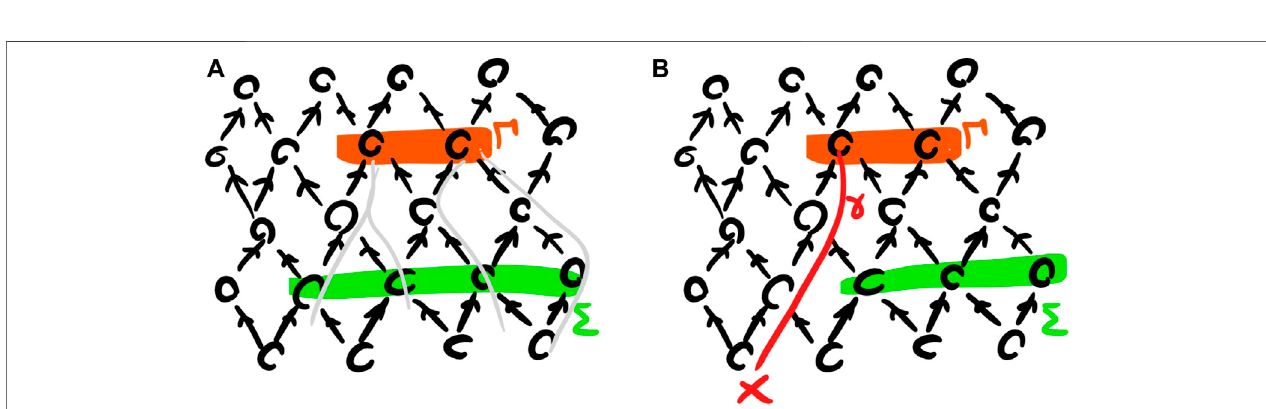
FIGURE2| (A) : twoslices Σ , Γ such that Σ 9 Γ . (B) : twoslices Σ , Γ such that Σ 9 & doublehyphen ; 9 pt / Γ , highlighting apast-directed path γ starting from anevent of Γ and not intersecting Σ at any point.